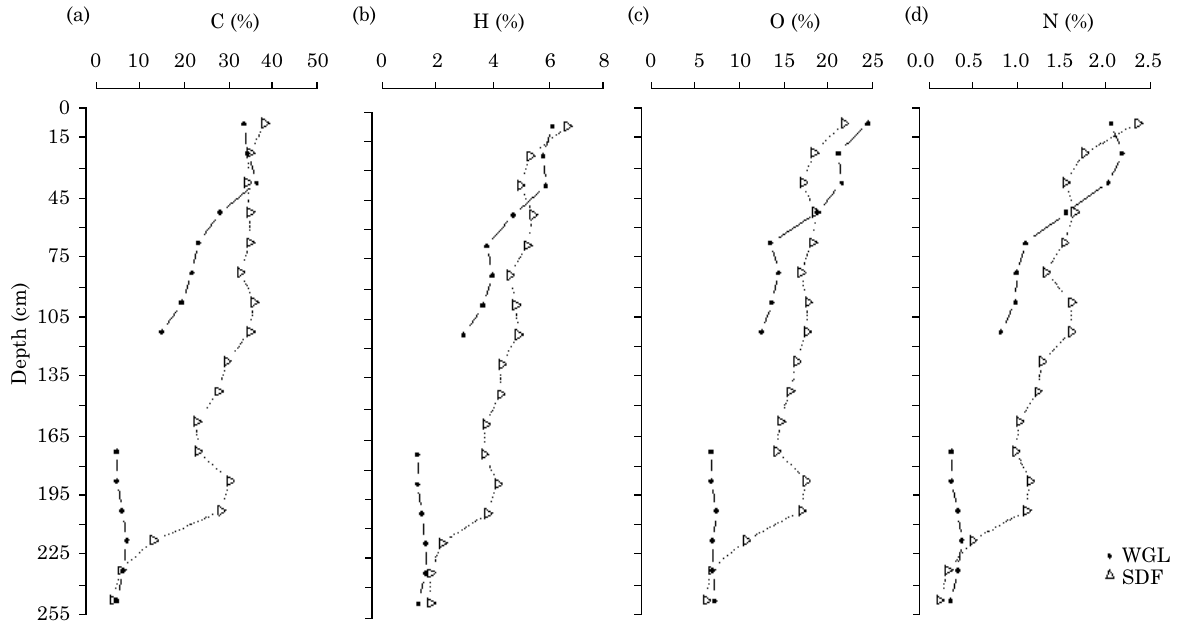
Figure 2. Average contents of (a) carbon (%C), (b) hydrogen (%H), (c) oxygen (%O), and (d) nitrogen (%N) in depth in core samples under wet grassland (WGL) and semi-deciduous forest (SDF) from the peat in the headwaters of the Rio